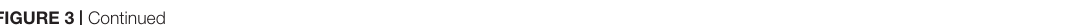
Frontiers in Microbiology |